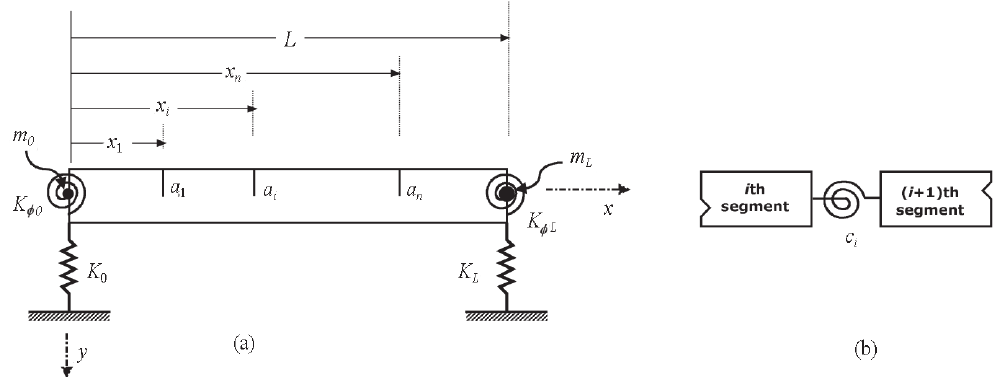
Fig. 1. Euler-Bernoulli beam having n cracks (a), crack modelling as rotational spring